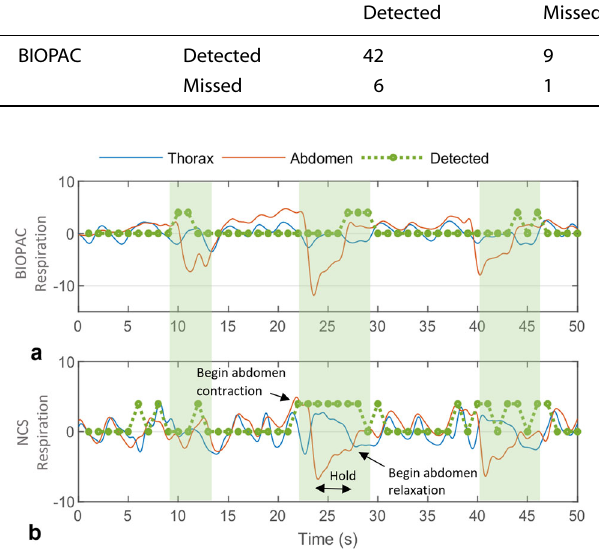
Fig. 4 An example of normalized thorax and abdomen respiration waveforms during the isovolumetric maneuver by one partici- pant. a Normalized BIOPAC chest-belt waveforms and b Filtered NCS respiration waveforms. The intended paradoxical motion windows are marked by green-shaded areas and detected instances are shown by the positive value of dotted green lines. Timing of abdomen contraction, hold, and relaxation is denoted during the second cycle of the NCS waveform. Both BIOPAC and NCS can detect all three instances of paradoxical abdomen-thorax